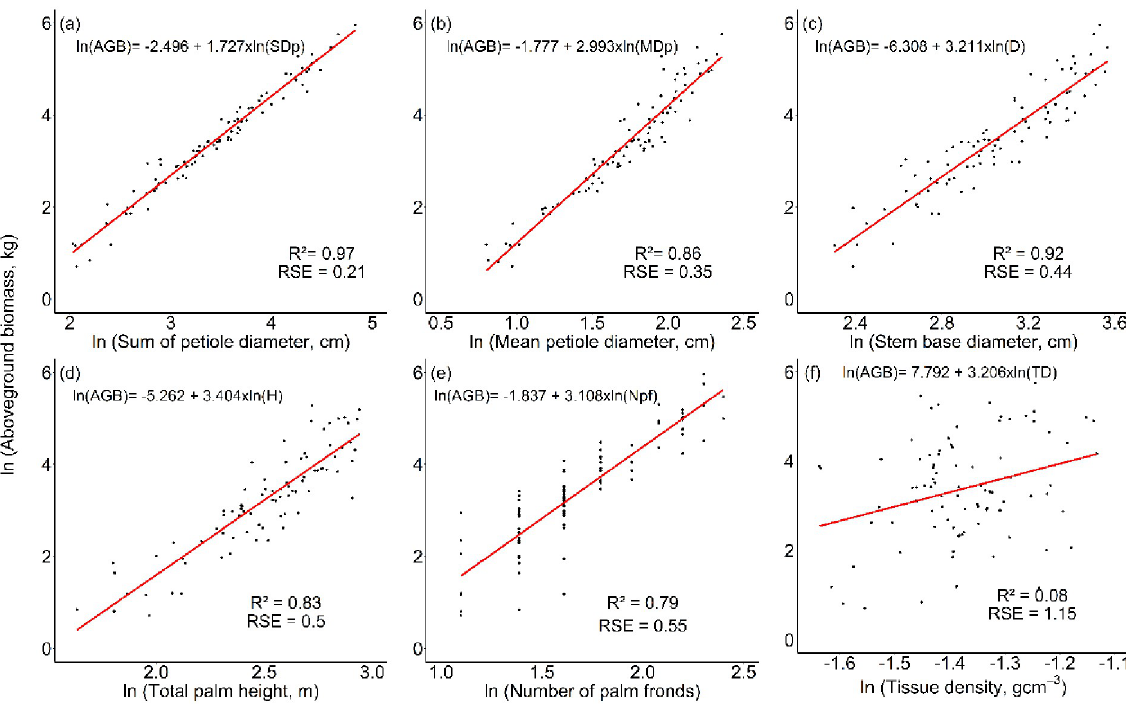
Fig 4. Allometric relationships between the aboveground biomass of R . laurentii individuals and each single predictor variable.